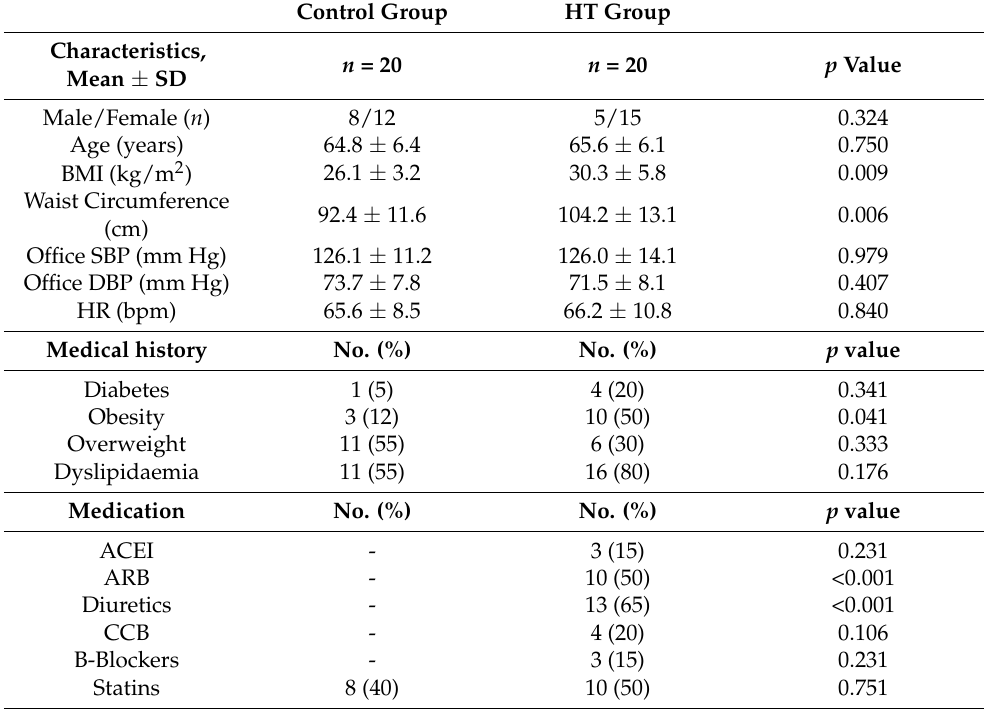
Table 1. General characteristics and medication of the